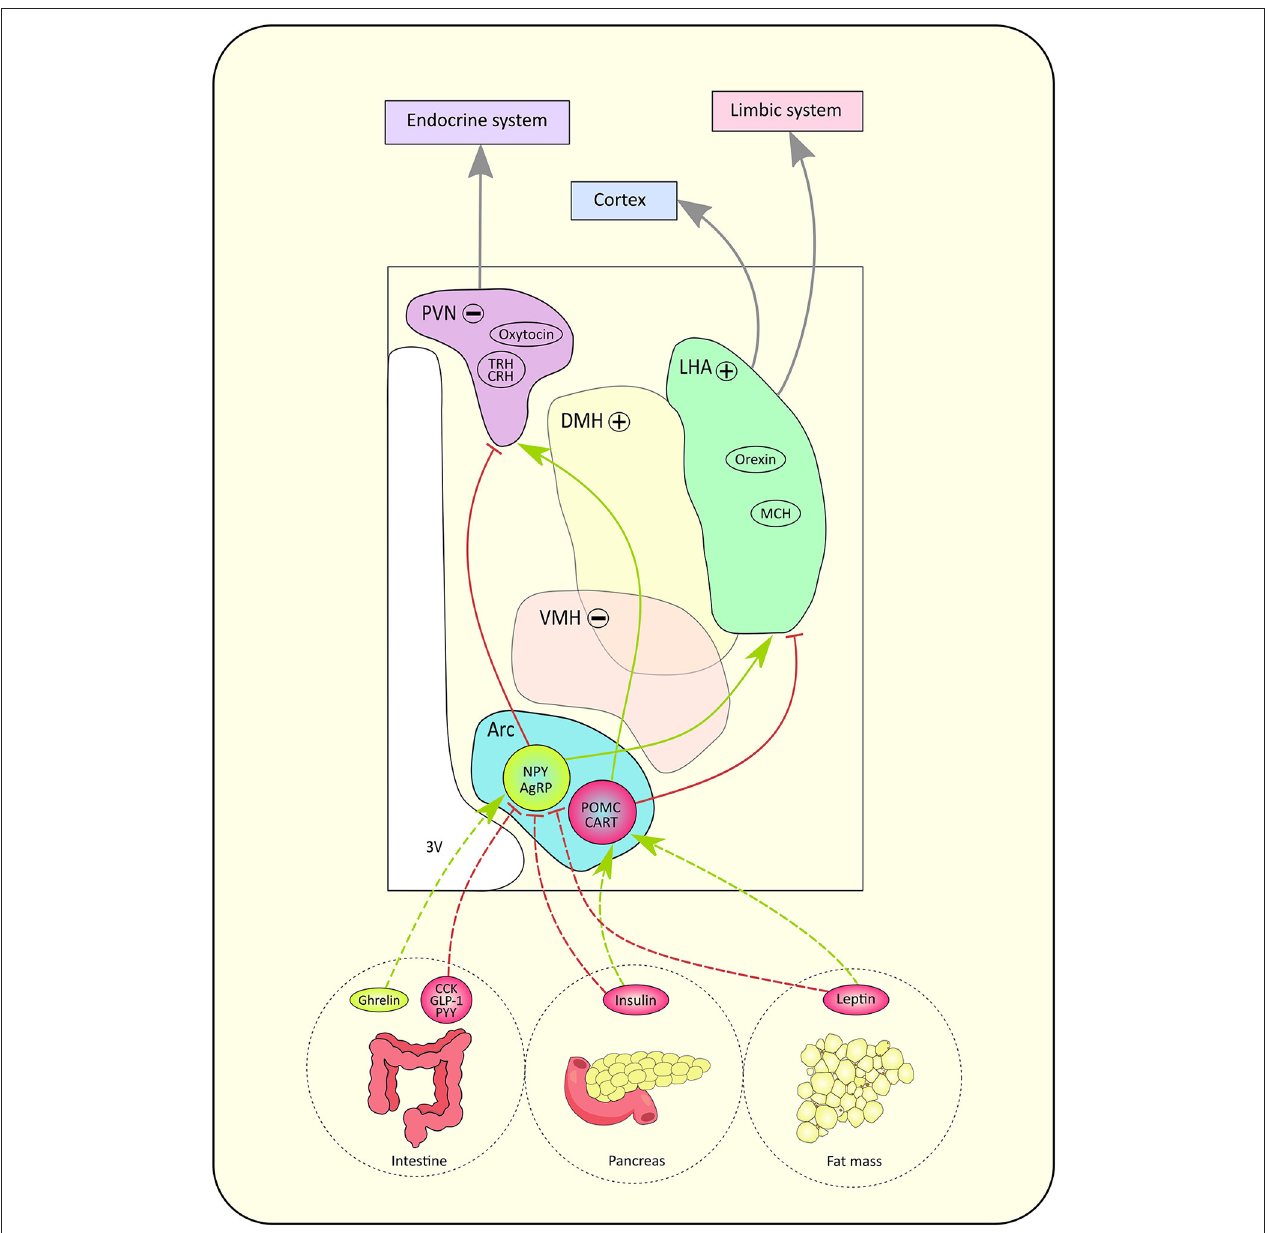
FIGURE 2 | Schematic pathway of the lipostat and its peptidergic circuitry. According to hunger state, hormones are released by the intestine, pancreas and fat mass. Those signals directly influence neuronal activity in the hypothalamus through their action on antagonistic neurons located in the arcuate nucleus (Arc): orexinergic neurons expressing neuropeptide Y (NPY)/ agouti-related peptide (AgRP) and anorexinergic neurons expressing pro-opio-melanocortine (POMC)/ cocaine- and amphetamine- regulated transcript (CART). Gut hormones such as cholecystokinin (CCK), peptide YY (PYY), glucagon-like peptide 1 (GLP-1) inhibit NPY/AgRP neurons while ghrelin stimulates NPY/AgRP neurons. The pancreas secretes insulin while leptin is secreted by fat mass cells. Both hormones trigger the inhibition of NPY/AgRP neurons but the stimulation of POMC/CART neurons. Red arrows represent inhibitory connections, green arrows represent stimulatory connections, gray connections represent indirect pathways. The paraventricular nucleus (PVN) hosts neurons expressing oxytocin, thyrotropin-releasing hormone (TRH) and corticotropin-releasing hormone (CRH), while the lateral hypothalamic area (LHA) contains neurons expressing orexin and melanin-concentrating hormone (MCH). The ’ + ’ sign means the nucleus has an orexinergic effect on food intake when activated, whereas the ’ − ’ sign indicates that the nucleus has an anorexinergic effect on food intake when activated. Indeed, when activated, the dorsomedial hypothalamus (DMH) and lateral hypothalamic area (LHA) have an orexinergic action while the ventromedial hypothalamus (VMH) and paraventricular nucleus (PVN) have an anorexinergic action on food intake. Finally, the PVN sends information to the endocrine system while the LHA carries input to the cortex and limbic systems (24). 3V, third ventricle.